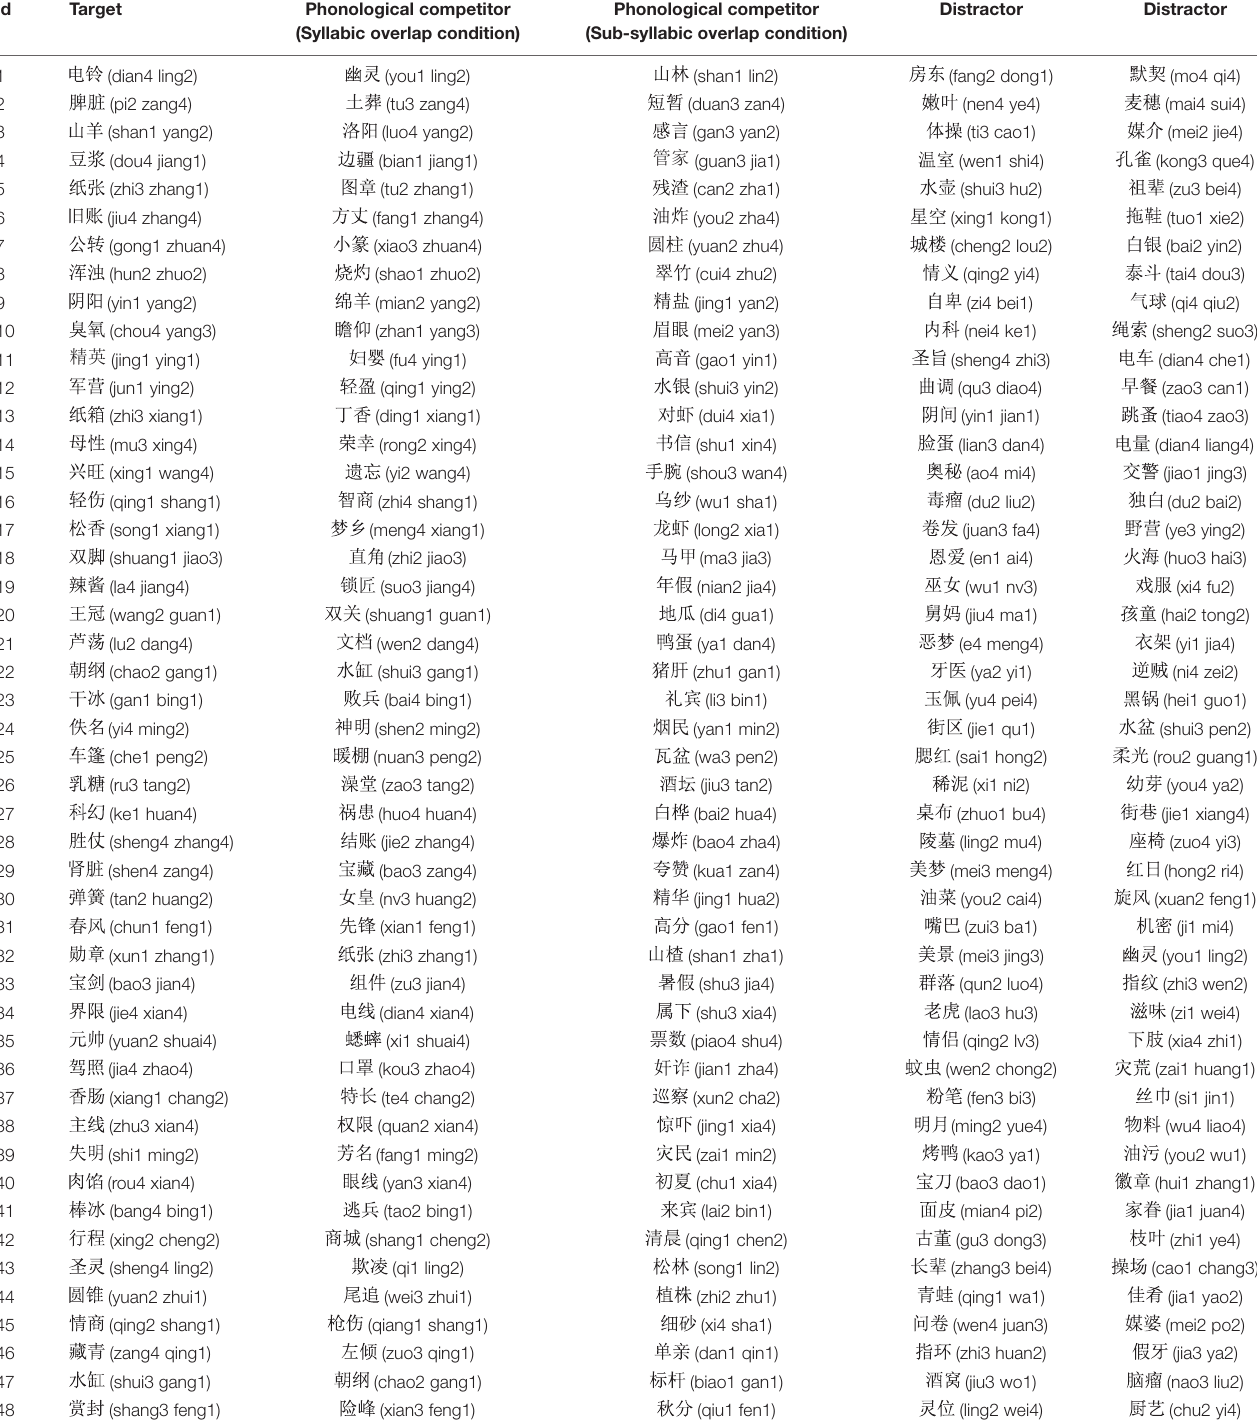
TABLE A1 | Materials used in Experiments 1 and